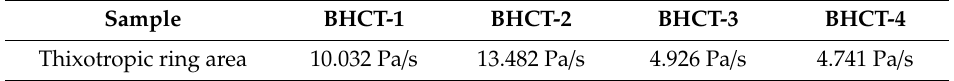
Figure 10. Shear thixotropy of composite gels at different crosslinker concentrations. Table 4. Area of thixotropic ring of composite gel under different crosslinker concentrations.